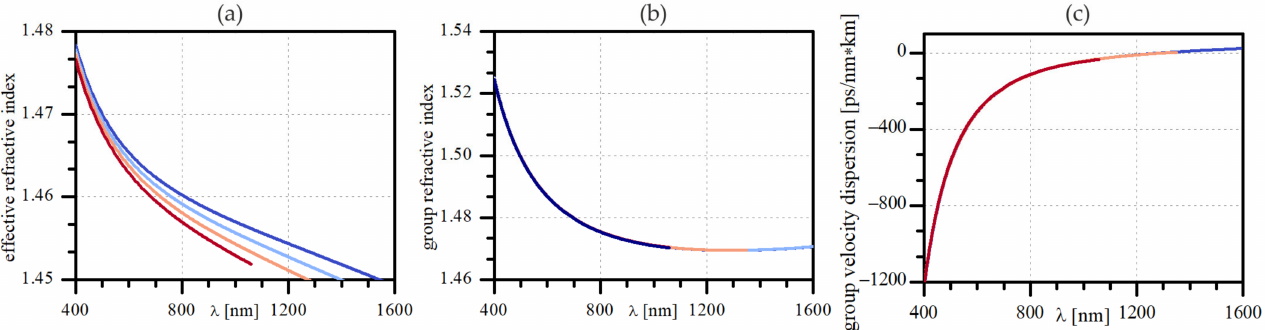
Figure 1. Spectral characteristics of analyzed few-mode fiber: ( a ) effective refractive index for fundamental mode (dark blue line) and a few higher-order modes: LP 11 (blue line), LP 02 and LP 21 (orange line), LP 31 and LP 12 (red line); ( b ) group refractive index for LP 01 and LP 11 (blue line), LP 02 and LP 21 (orange line) and LP 31 and LP 12 (dark blue line); ( c ) group velocity dispersion for LP 01 and LP 11 (dark blue), LP 02 and LP 21 (orange line) and LP 31 and LP 12 (red